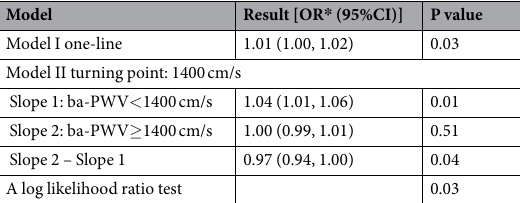
Model Result [OR * (95%CI)] P value